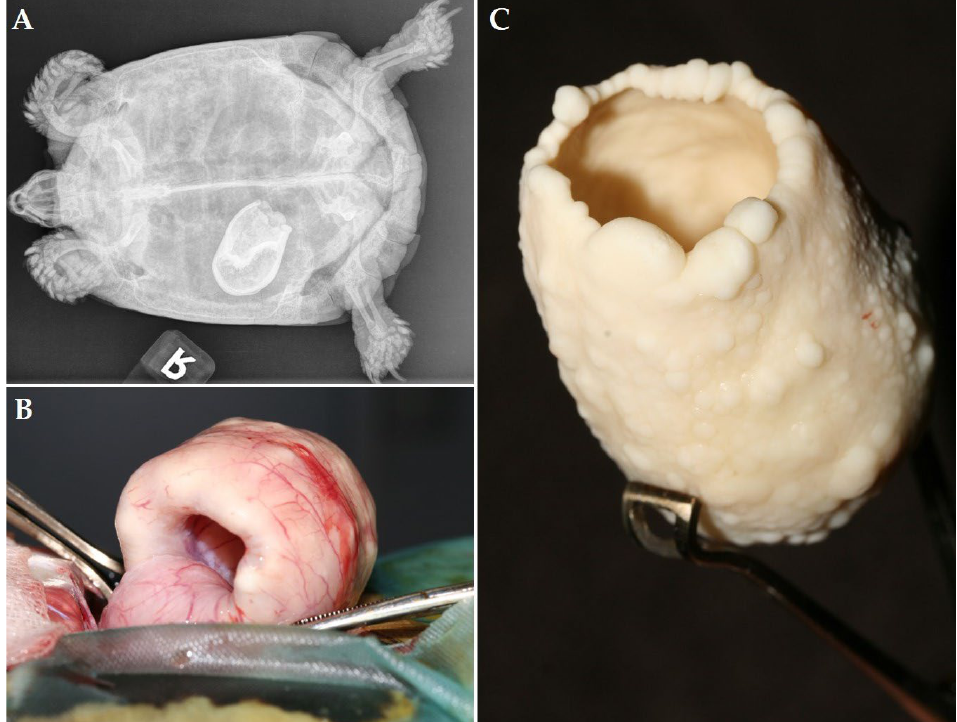
Figure 6. ( A ). Dorsoventral radiograph of a Hermann’s tortoise ( Testudo hermanni ) showing a large, retained egg with an abnormal shape in the left caudal coelomic cavity. ( B ). Intraoperative view during transplastron coeliotomy exteriorization of the oviduct containing the retained egg. ( C ). The egg after surgical removal from the oviduct.